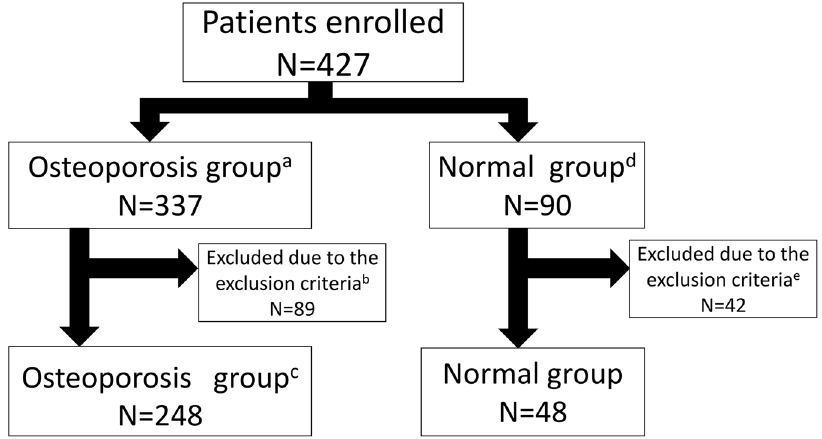
Figure 1. Flow chart of study subjects. Informed consent was obtained from 427 subjects, and 337 and 90 were diagnosed as osteoporosis and normal (non-osteoporosis) based on diagnostic criteria of either bone mineral density lower than a − 2.5 SD T-score or current hip fracture history. 89 and 42 subjects were excluded from osteoporosis and normal groups, respectively, due to incomplete datasets or a history of rheumatoid arthritis (RA), diabetic myelitis (DM) cancer, or corticosteroid use. Subjects taking osteoporosis drugs were excluded from the normal group. ( a ) The Osteoporosis group was defined by either lower than a − 2.5 SD T-score of BMD or hip fracture. No subjects had previous hip fracture history. ( b ) Cases (89) with history of or under treatment for conditions cited above were excluded. ( c ) Group includes 92 subjects diagnosed as osteoporosis with hip fracture. ( d ) Defined by a T-score greater than − 2.5 SD without fragility fracture (includes patients with osteopenia). ( e ) Cases (42) excluded based on criteria cited